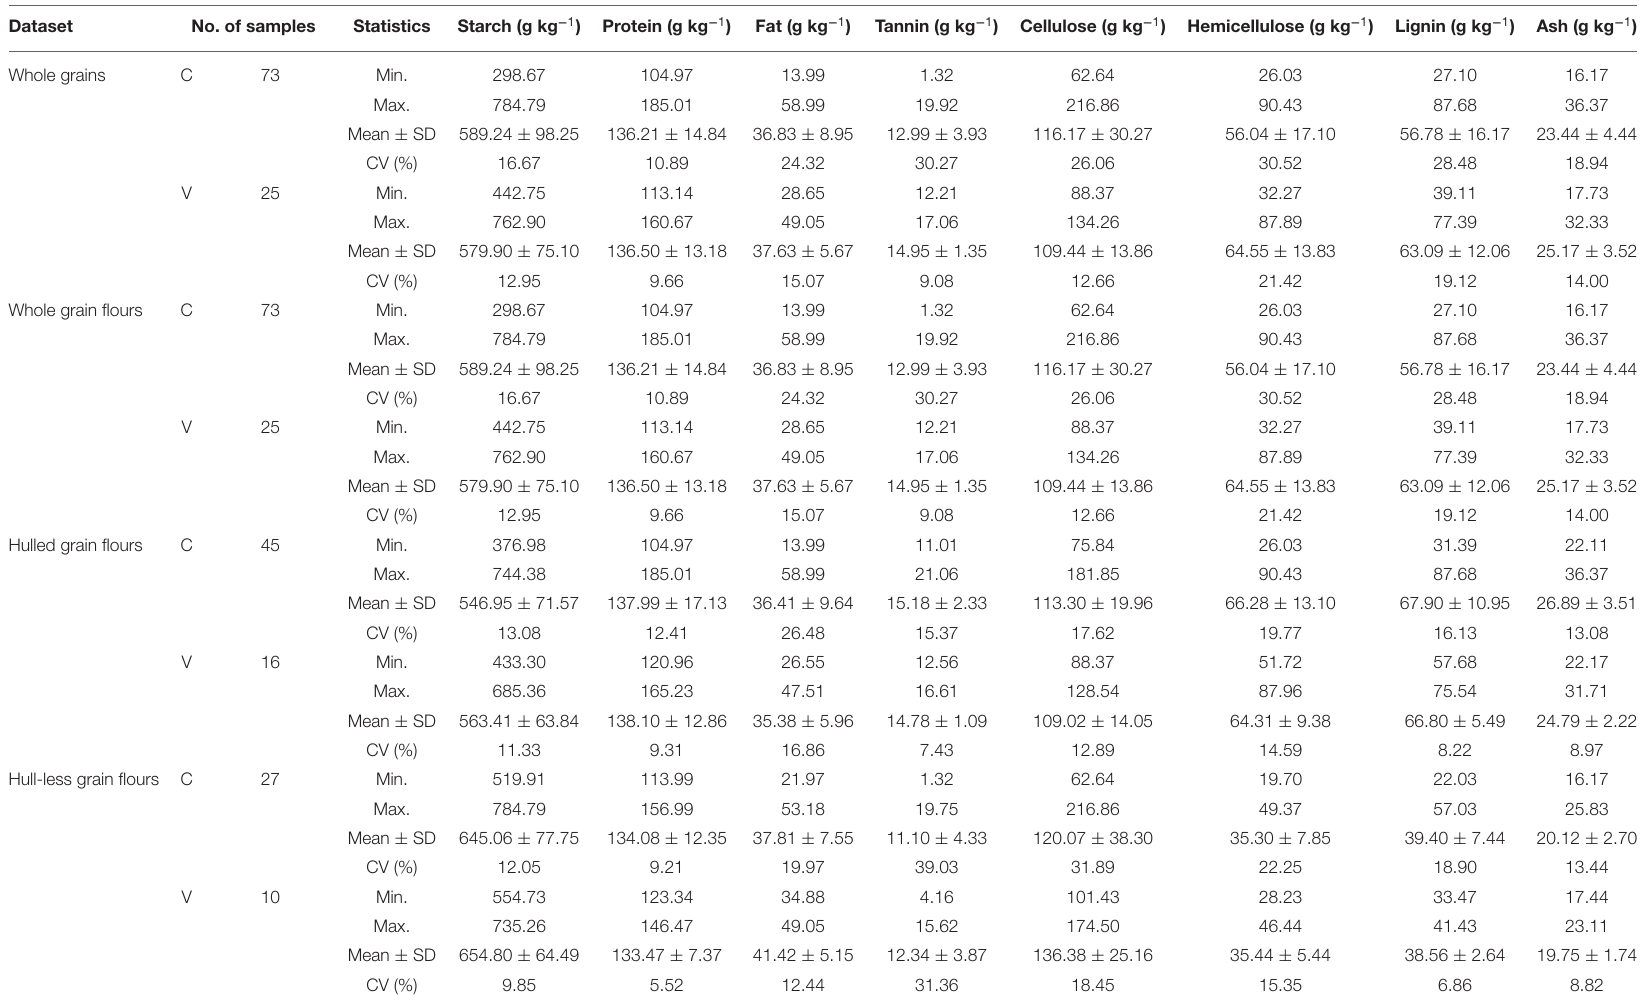
TABLE 1 | Descriptive statistics [minimum (min), maximum (max), mean, SD, and coefficient of variation (CV)] of laboratory analytical data comprising starch, protein, fat, tannin, cellulose, hemicellulose, lignin, and ash contents of distinct types of sorghum grains (whole grains, whole grain flours, hulled grain flours, and hull-less grain flours), used as reference data for calibration (C) and validation (V) subsets to construct PLSR models.